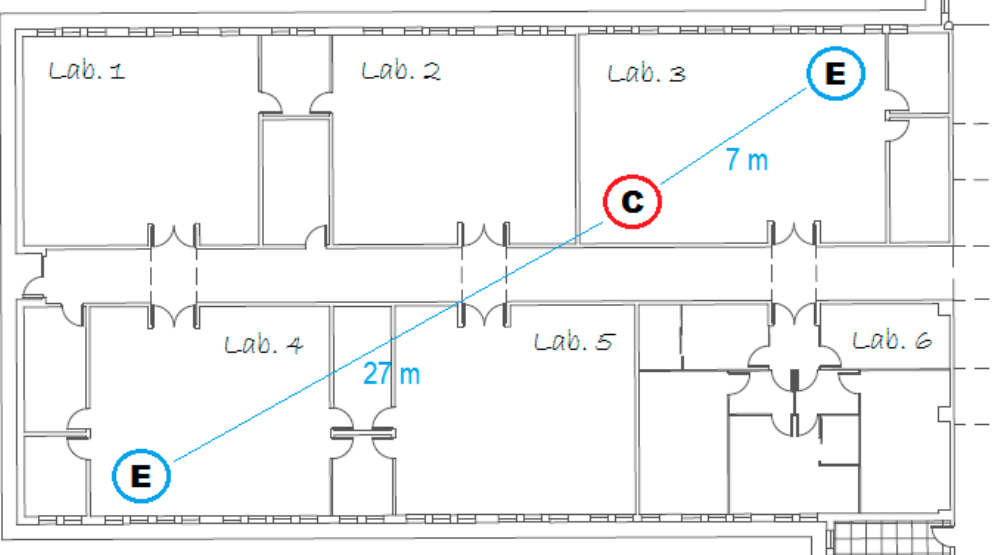
Figure 2. Polytechnic Institute of Guarda Laboratory plan.